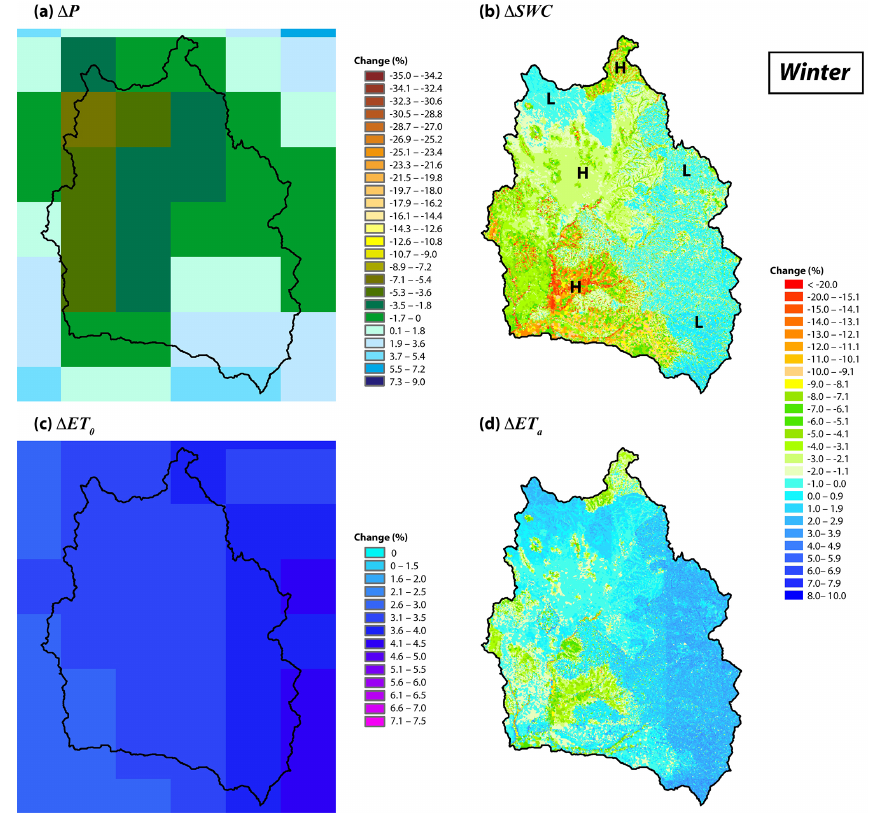
Figure 13. Changes between REF and FUT periods averaged over the winter season (December–February) for (a) P , (b) SWC, (c) ET 0 , and (d) ET a under the ECH–RCA combination. In (b) , areas where the variables are characterized by positive or lower negative changes are indicated with L , while regions with higher negative changes are indicated with H